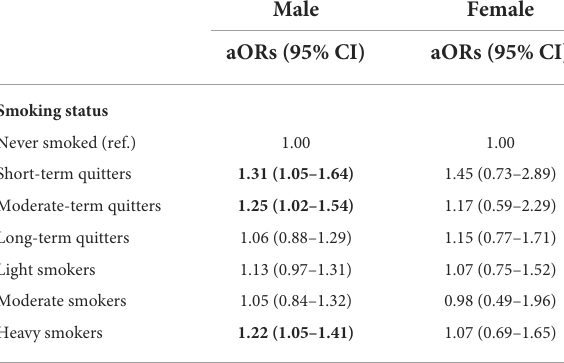
TABLE 6 Fixed effects logistic regression analysis of depressive symptoms stratified by